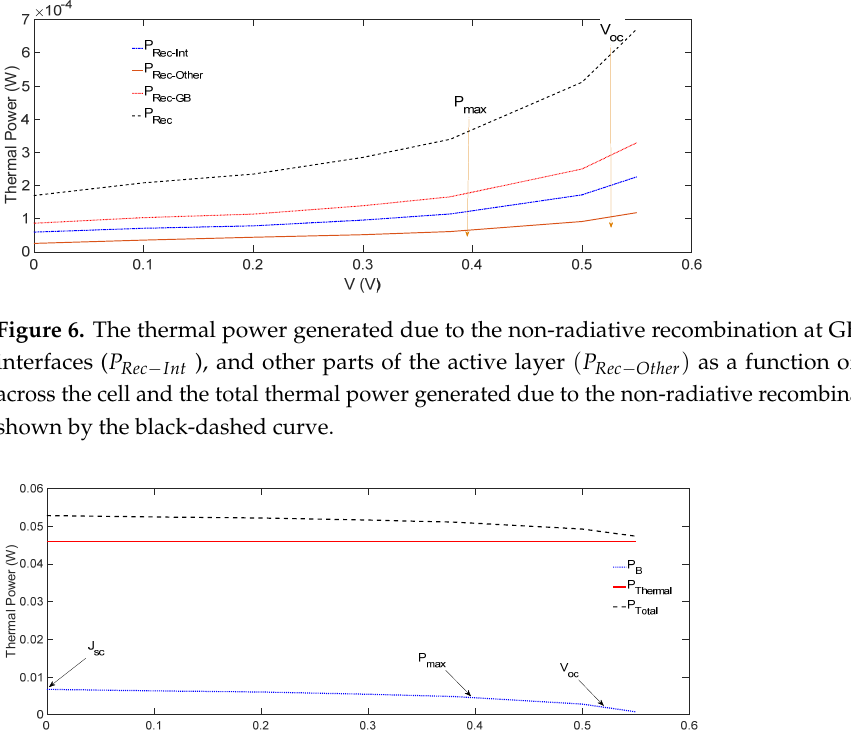
Figure 5. The simulated operating temperature of the OSC as a function of voltage. 𝐽 (cid:3046)(cid:3030) , 𝑃 (cid:3040)(cid:3028)(cid:3051) and 𝑉 (cid:3042)(cid:3030) marked by arrows.